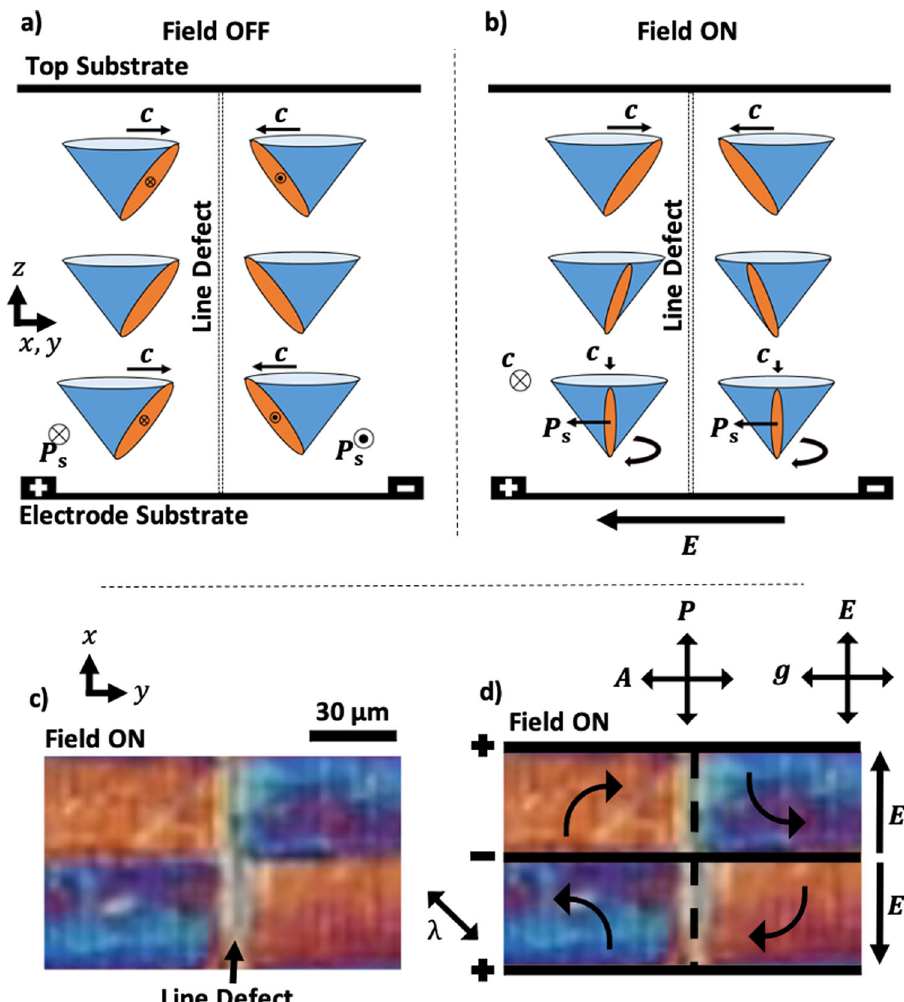
Fig. 5 Defect origin in the VGA-FLC device. a and b A schematic diagram showing the origin of the defects that arise on a homeotropic grating. a Field OFF and b Field ON. As the c -director is initially at a 180° twist over the defect, an applied in-plane electric fi eld will rotate the c -director in opposite directions. c , d Experimental polarising optical microscopy results showing how a full-wave plate is used to determine the direction of the c -director with a small electric fi